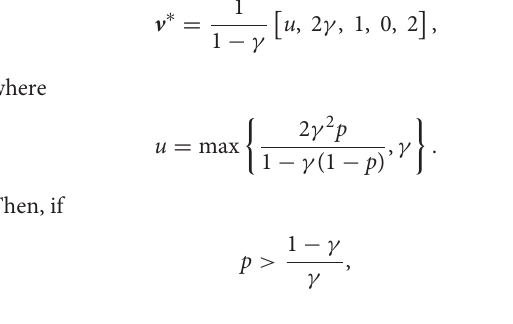
and π ∗ ( r ( D )). In the remainder of the paper, we also adhere